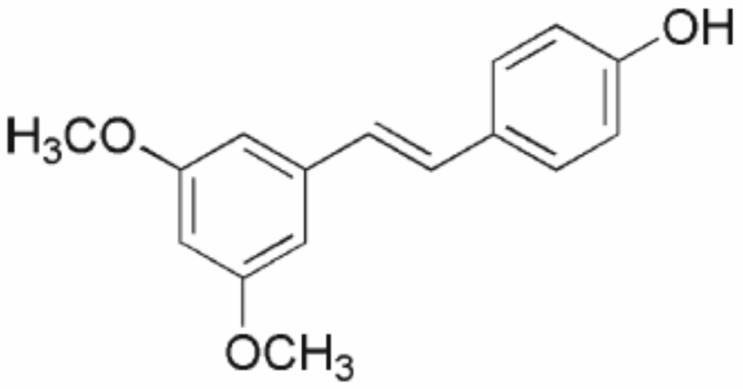
Figure 1. Chemical structure of thymoquinone